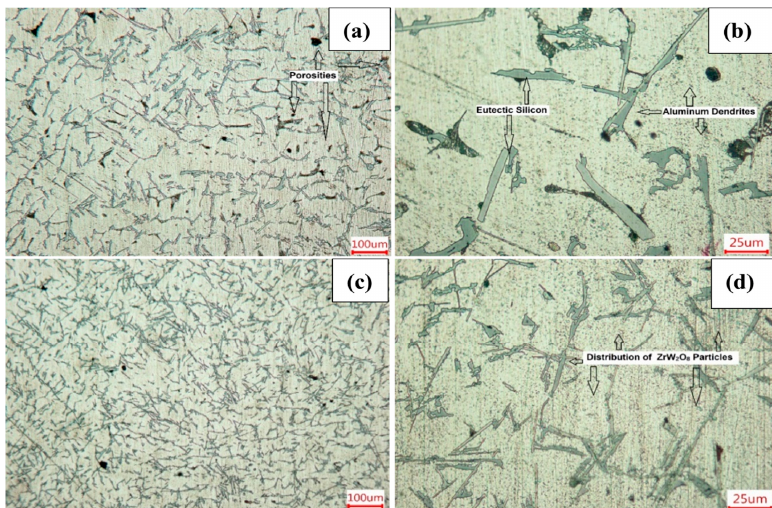
Figure 5. Optical micrographs of base Al-alloy and ceramic-reinforced composite: ( a ) low magnification of base alloy displaying the distribution of porosity, ( b ) high magnification of base alloy showing the microstructure of eutectic silicon particles and aluminum dendrites, ( c ) low magnification of composite showing the eutectic structure, and ( d ) high magnification of composite showing the distribution of ZrW 2 O 8 into aluminum alloy.